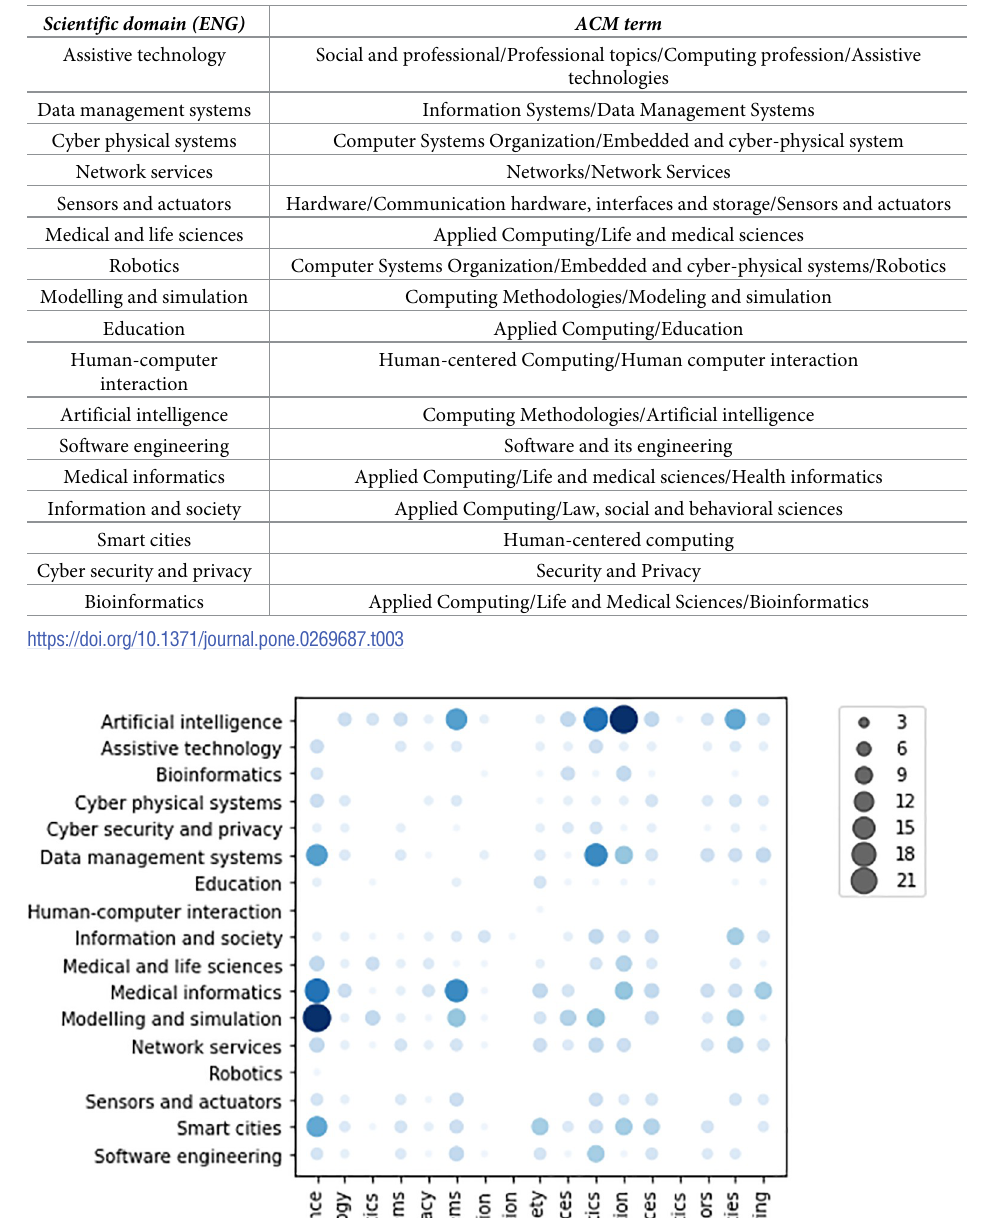
Table 3. Mapping between the systems used in this review to describe scientific domains and the ACM terminology.